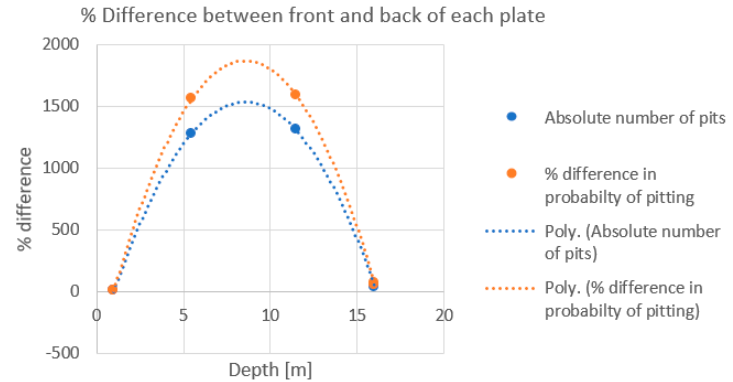
Figure 10. Difference between pits in terms of probability of pitting.